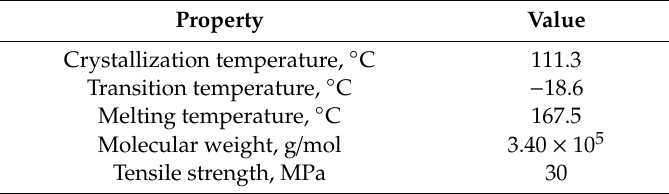
Table 6. Thermal and mechanical properties of the considered polypropylene.